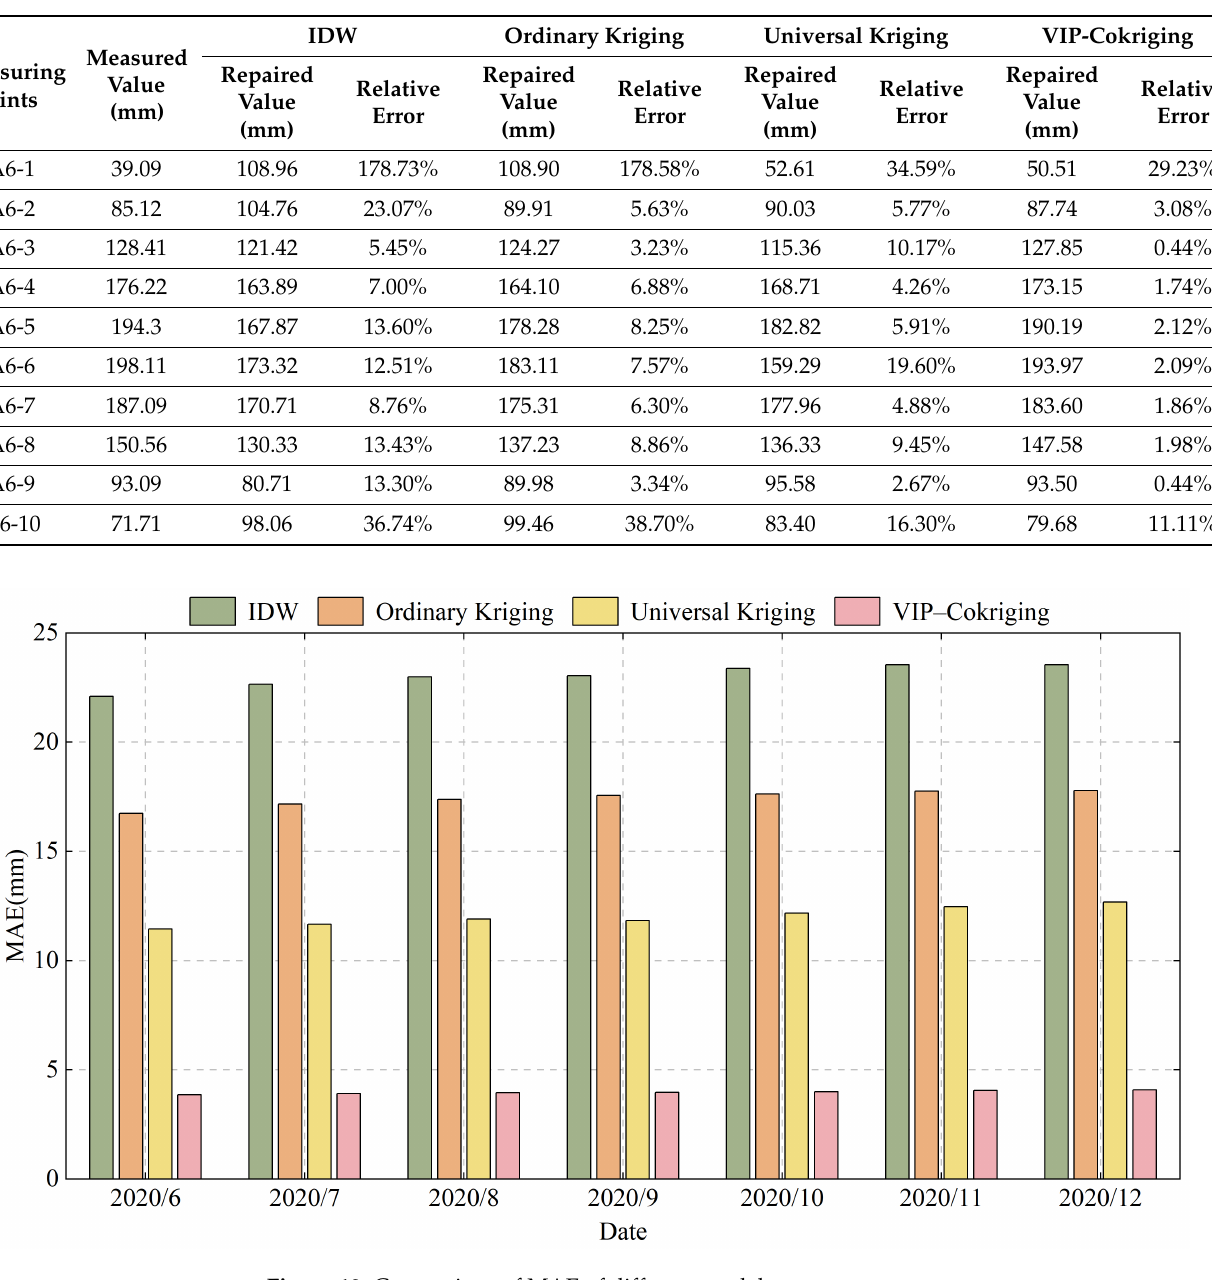
Table 3. Comparison between measured values and repaired values of different models (24 December 2020).